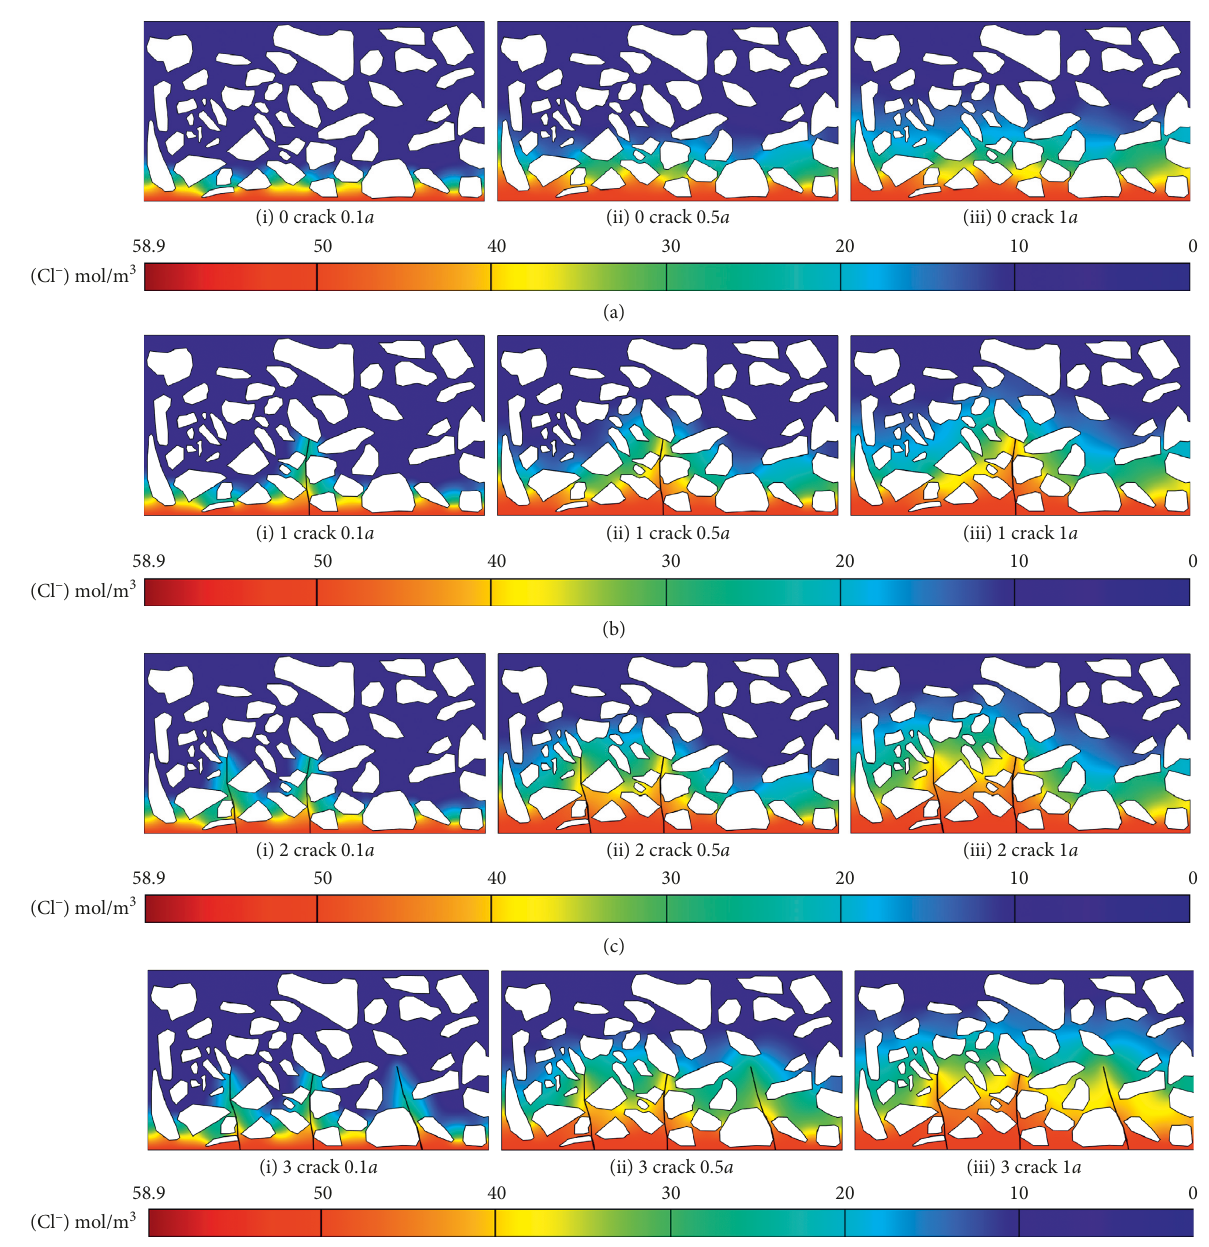
Figure 9: Concentration distribution profiles of chloride ions in concrete with different crack quantities within 1 year. (a) Uncracked concrete and concrete with (b) 1